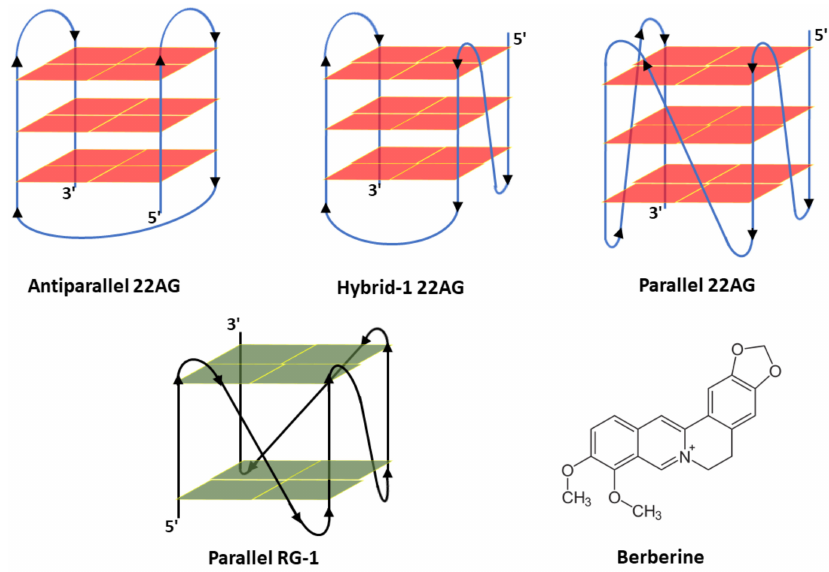
Figure 1. Schematic representation of the possible structures of the human telomeric DNA quadruplex 22AG (antiparallel, hybrid-1, and parallel) and the RNA quadruplex from the genome of SARS-CoV-2, RG-1 (parallel). The chemical structure of the ligand berberine is also